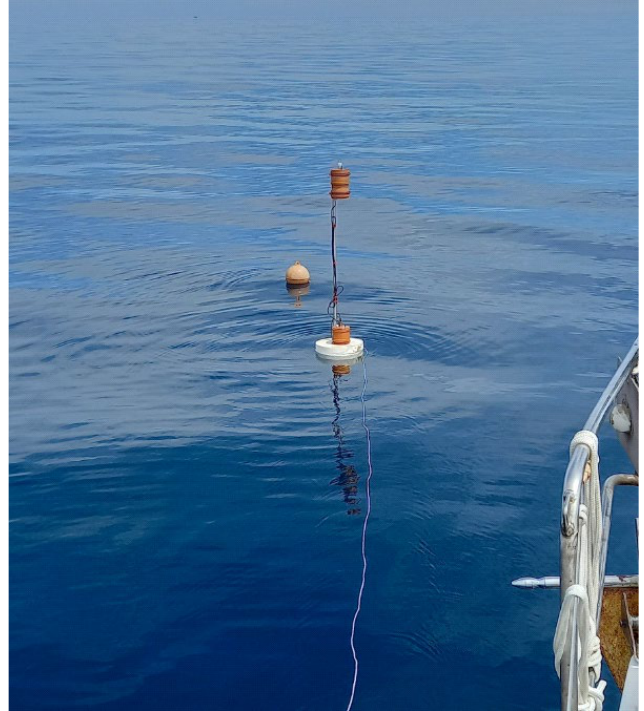
Figure 5. View of the deployed beacon.